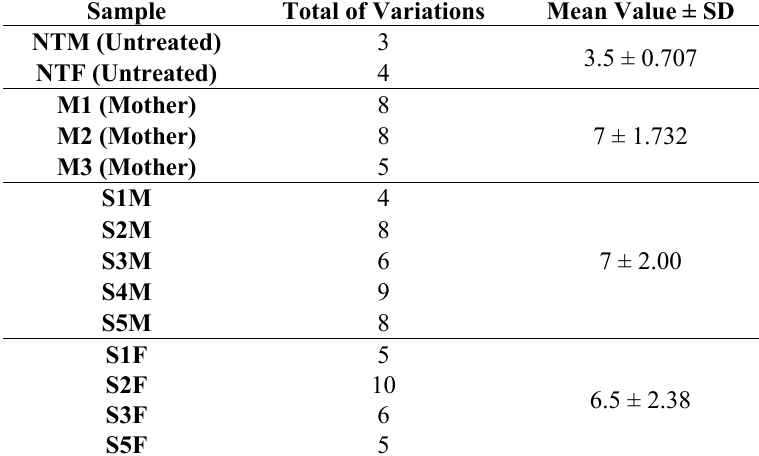
Table 1. Genomic methylation changes observed in DNA of untreated rats, mother (early life treated) and offspring F1 generation (untreated). NTM (untreated male controls) and NTF (untreated female controls) SM (male son rat) SF (female daughter rat).